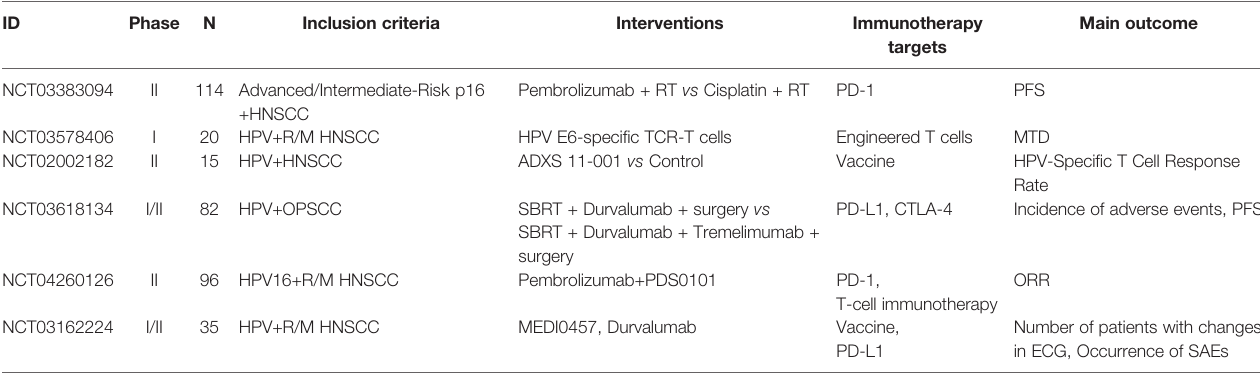
TABLE 3 | Ongoing clinical trials for HPV-positive